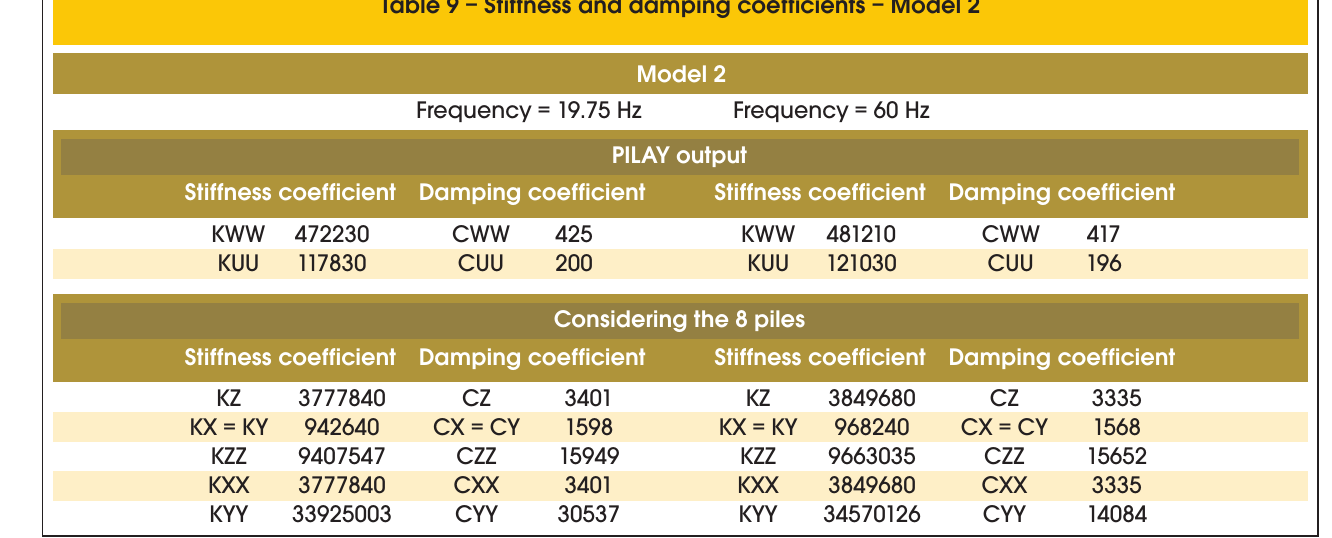
Table 9 – Stiffness and damping coefficients – Model